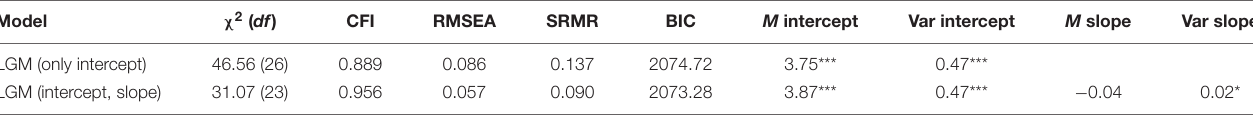
TABLE 1 | Fit indexes, means, and variances of the parameters for the linear growth models (LGM). Model χ 2 ( df ) CFI